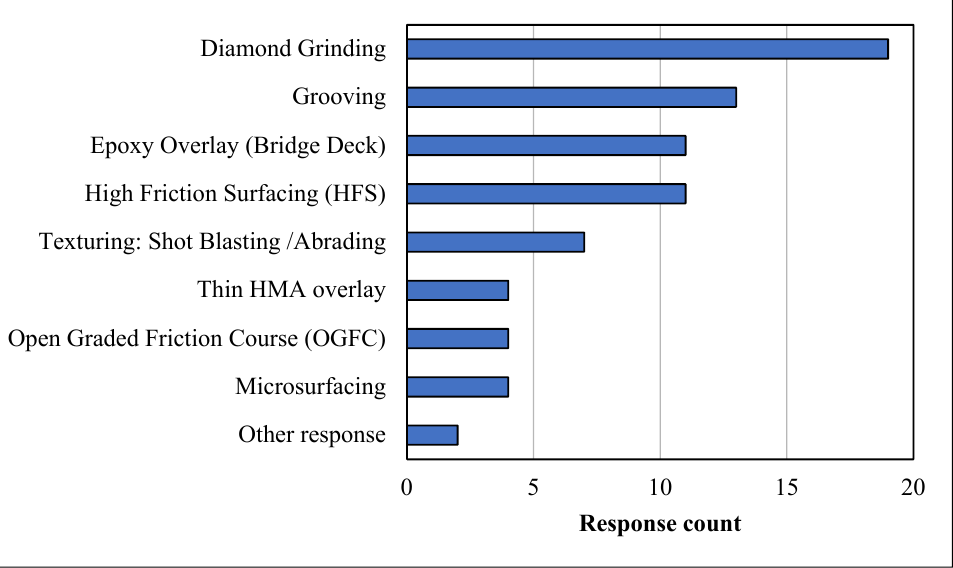
Figure 8. Types of pavement friction treatments considered for concrete pavement.